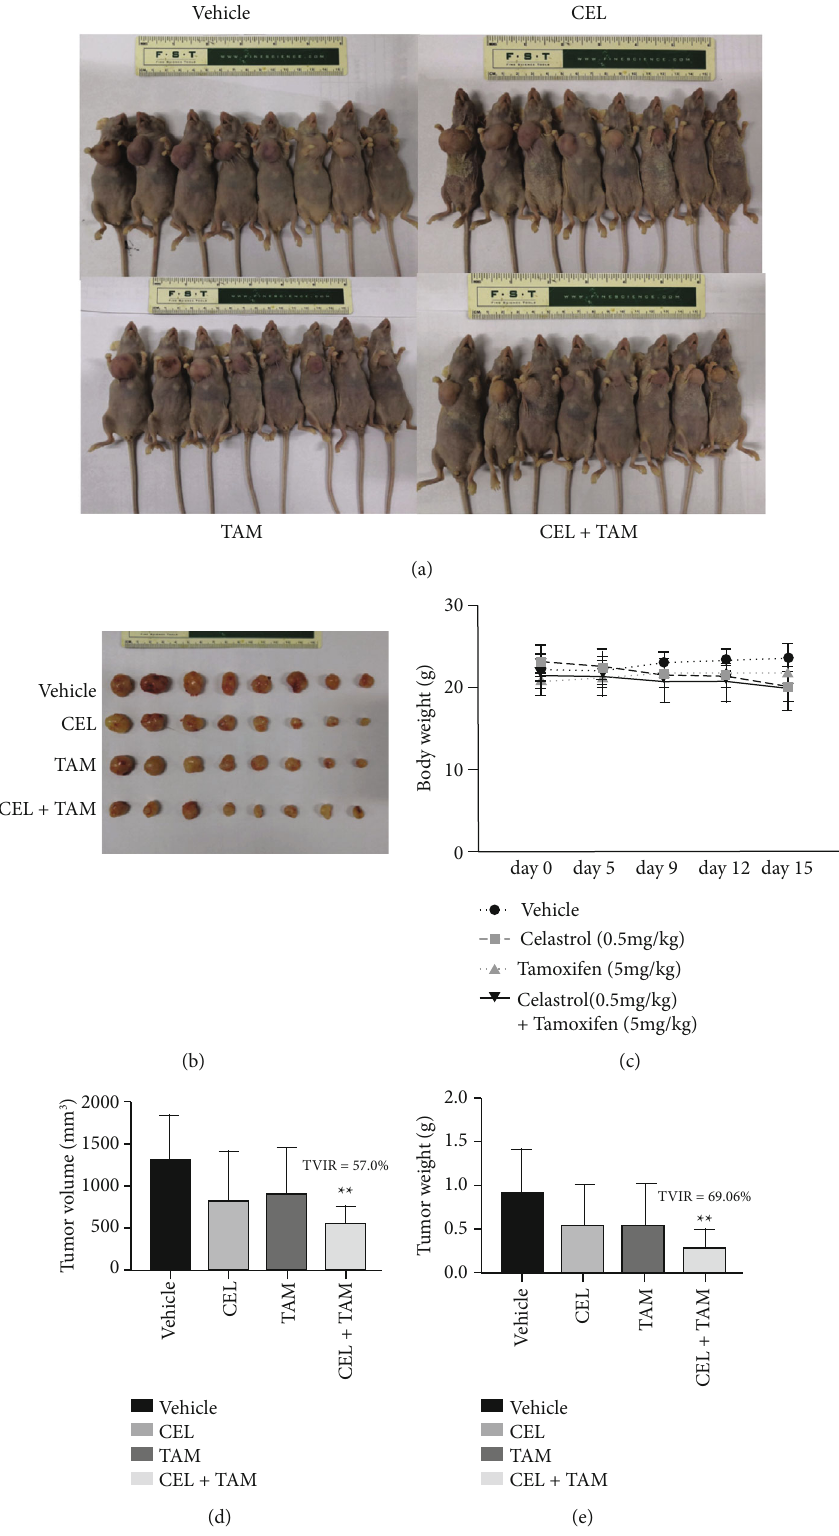
Figure 7: E ff ects of tamoxifen, celastrol, and the combination of tamoxifen and celastrol in MCF-7 tumour-implanted athymic BALB/c nude mice. The tumour-bearing mice were sacri fi ced on day 15. Representative photographs (a, b) of gross tumours in the mice in the vehicle, CEL, TAM, and CEL+TAM groups. Body weight (c), tumour volume (d), and tumour weight (e) were signi fi cantly decreased in the CEL+TAM group compared with the tamoxifen alone